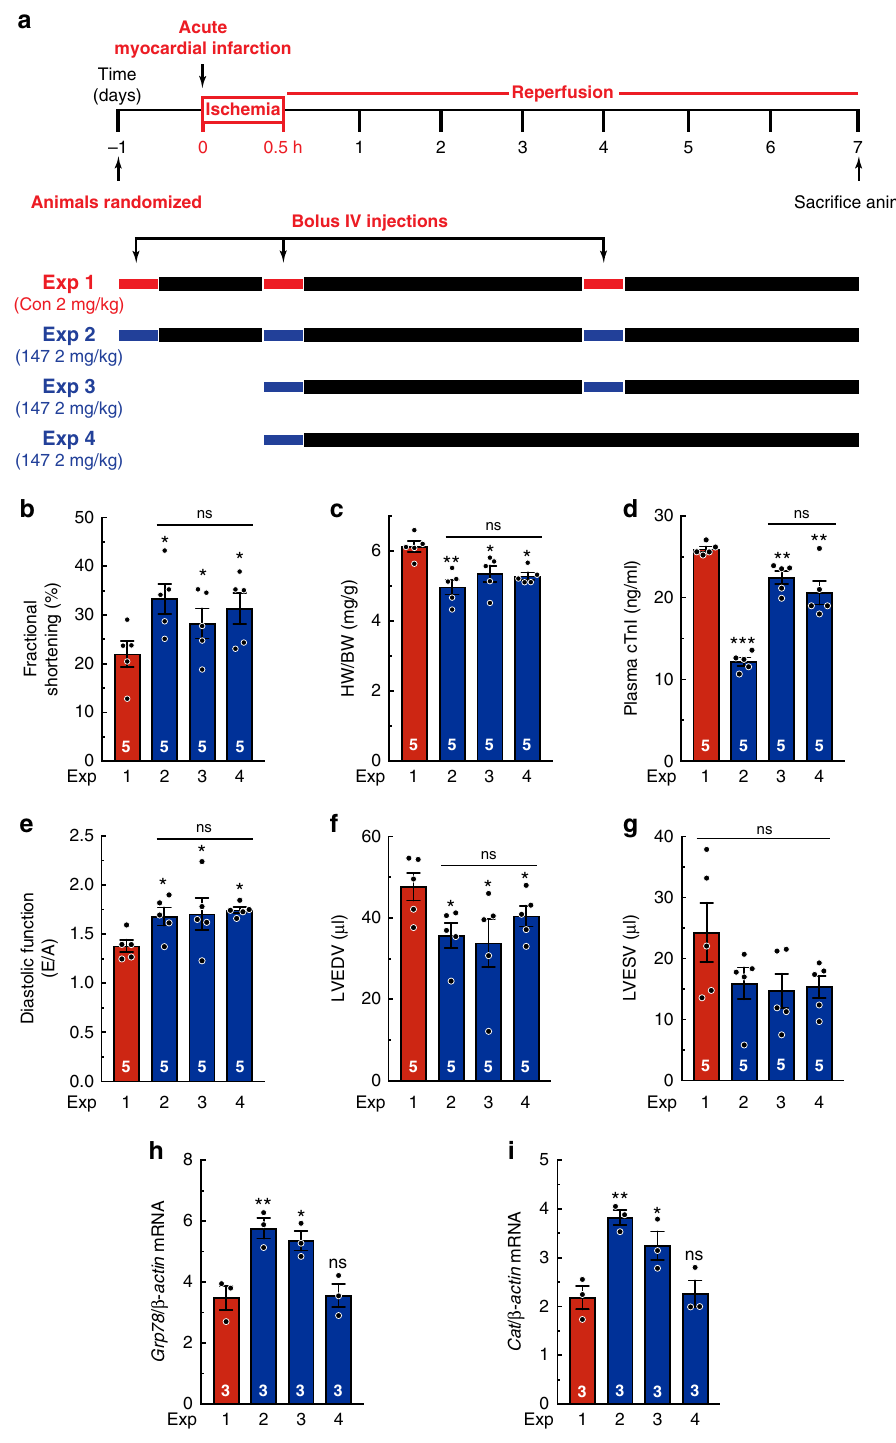
Fig. 7 147 improves cardiac performance 7 days post AMI. a Experimental design for testing the effects of 147 in the hearts of mice subjected to 30 min of myocardial infarction, and then examined 7 days after the initiation of reperfusion. Red bars depict the bolus administration of the control compound, while blue bars depict the bolus administration of 147 . b , f , g Echocardiographic parameters of fractional shortening ( b ), LV end diastolic volume (LVEDV) ( f ), and LV end systolic volume (LVESV) ( g ) ( n = 5). Detailed analyses of echocardiography parameters are in Extended Data Table 3. c Ratio of heart weight to body weight ( n = 5). d Plasma cTnI ( n = 5). e Diastolic function as determined by pulse-wave Doppler (PW) technique to analyze E and A waves ( n